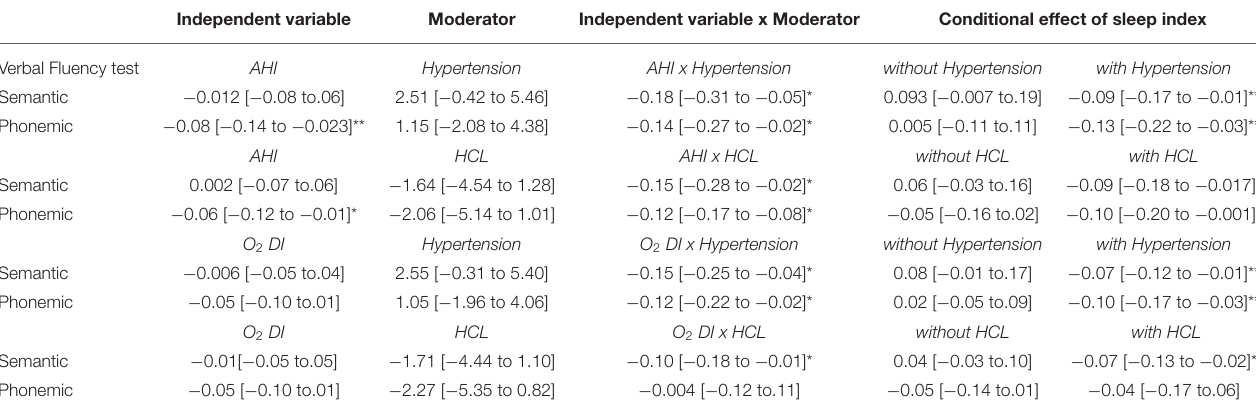
TABLE 3 | Unstandardized regression coefficients of OSAS severity and medical comorbidities on verbal fluency test